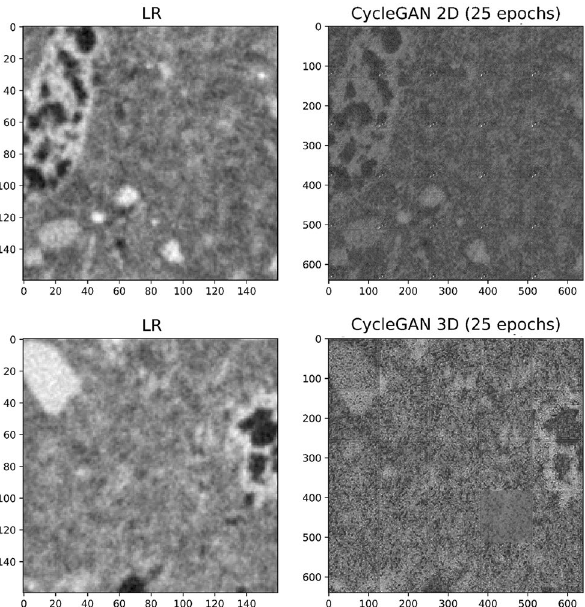
Figure 7. Super-resolved validation images: 2D and 3D networks trained on unpaired data. CycleGAN was trained both in 2D and 3D on unpaired data (i.e., using non-corresponding LR and HR images). LR (input) images are also shown for comparison. Correspondent training details are reported in Table 1. A relatively limited training of 25 epochs (455,625 and 5750 training steps in 2D and 3D) was possible in reasonable times due to the high computational costs (see also Table